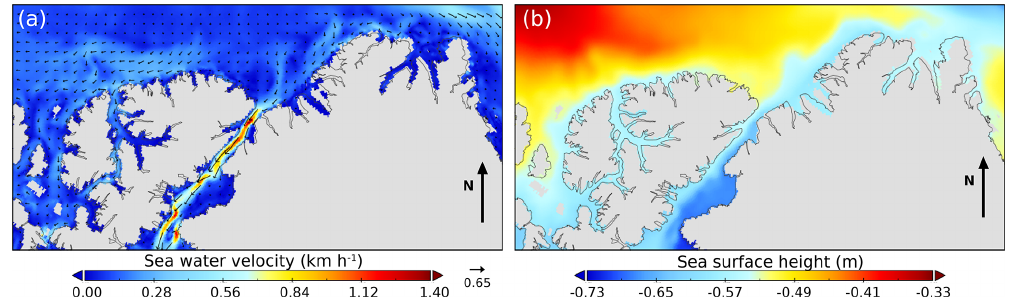
Figure 6. Maps of ocean current near the surface (a) and sea surface height (b) , averaged over December 2016 from GLORYS12V1, which is generated by the Copernicus Marine Environment Monitoring